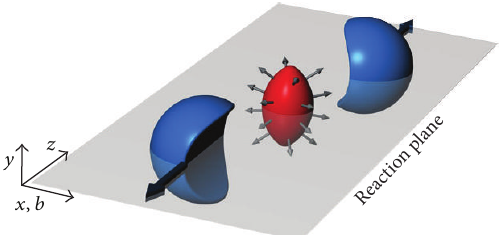
Figure 5: Schematic picture of a nonzero impact parameter colli-